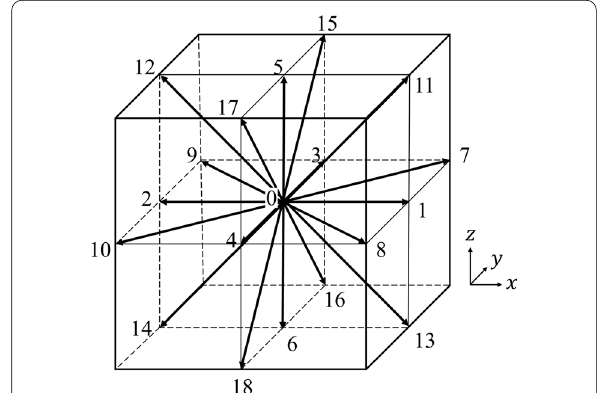
Fig. 1 Schematic of the particle velocity vector, c i , in the D3Q19 configuration of the lattice Boltzmann